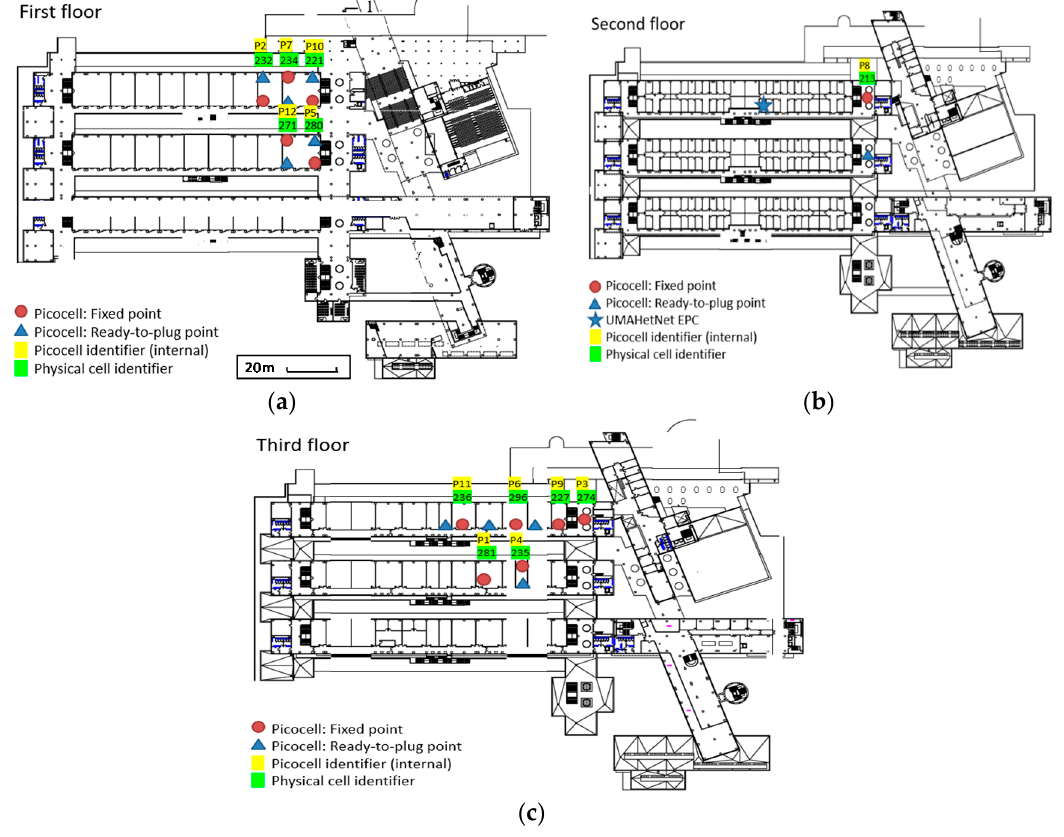
Figure 7. Picocell deployment in “Escuela Técnica Superior de Ingeniería de Telecomunicación” (ETSIT) throughout different floors.